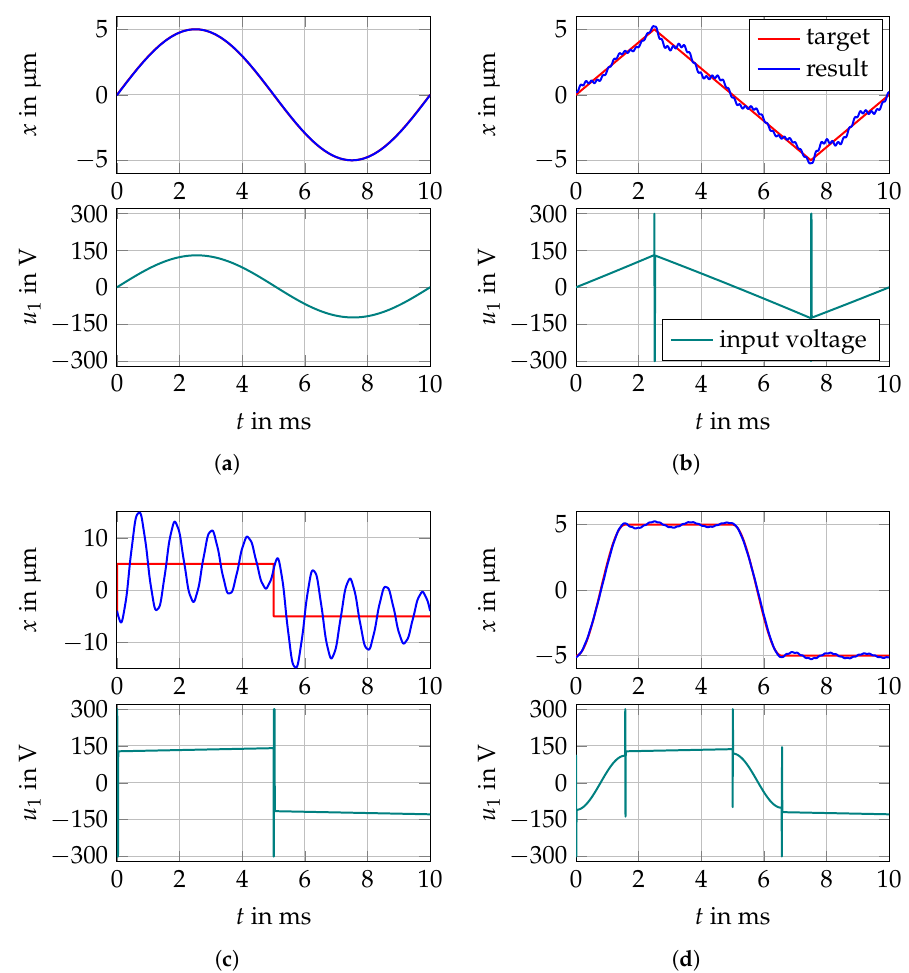
Figure 9. Simulation results of invers feed forward excitation. ( a ) sine wave signal; ( b ) triangular wave signal; ( c ) rectangular wave signal; ( d ) pseudo rectangular wave